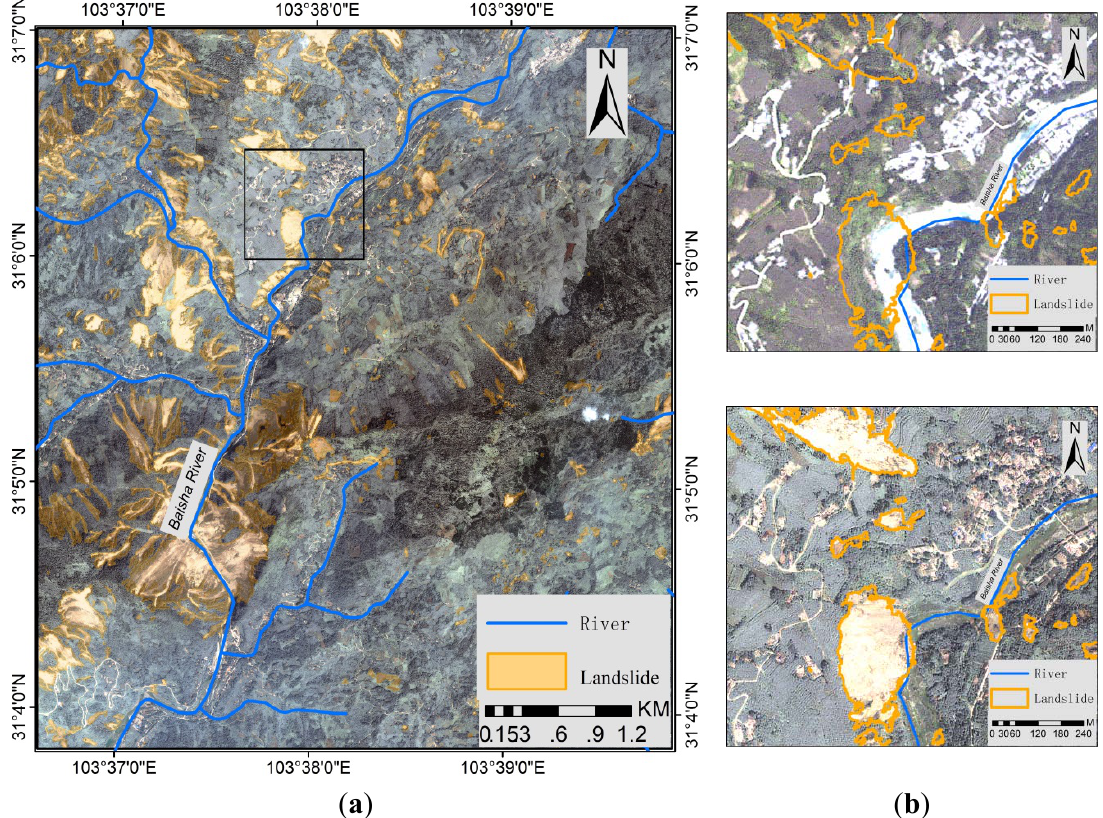
Figure 3. The landslides extracted from the two IKONOS images: ( a ) Landslide distribution overlaid on the post-event IKONOS and the river maps; and ( b ) A detailed landslide pattern (the outlined area in (a)) with a background of pre-event (upper) and post-event (lower) IKONOS